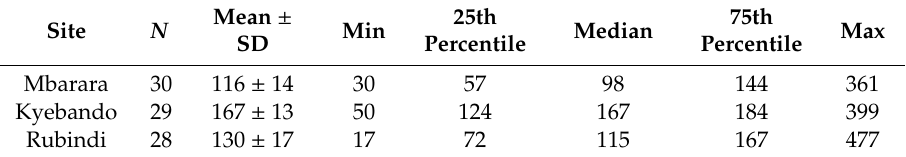
Table 1. Daily particulate matter (PM 10 ) concentrations ( µ g · m − 3 ) measured at three di ff erent locations. N is the number of samples; SD is the standard deviation of the mean as described in Section 2.3; Min and Max are the minimum and maximum observed values. All samples were collected for 24 h.